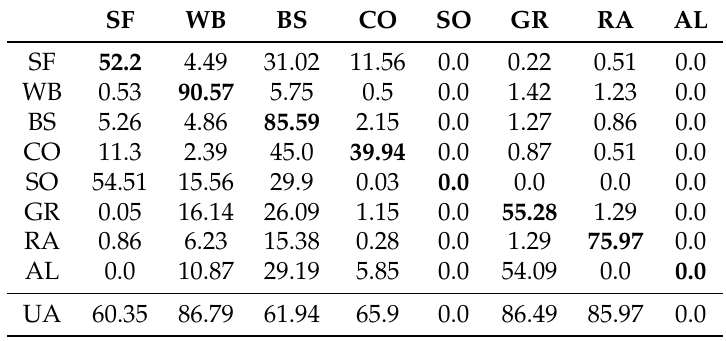
Table 12. Confusion matrix for 23-04-2015 using Sentinel-1 (7 images). κ = 0.66.